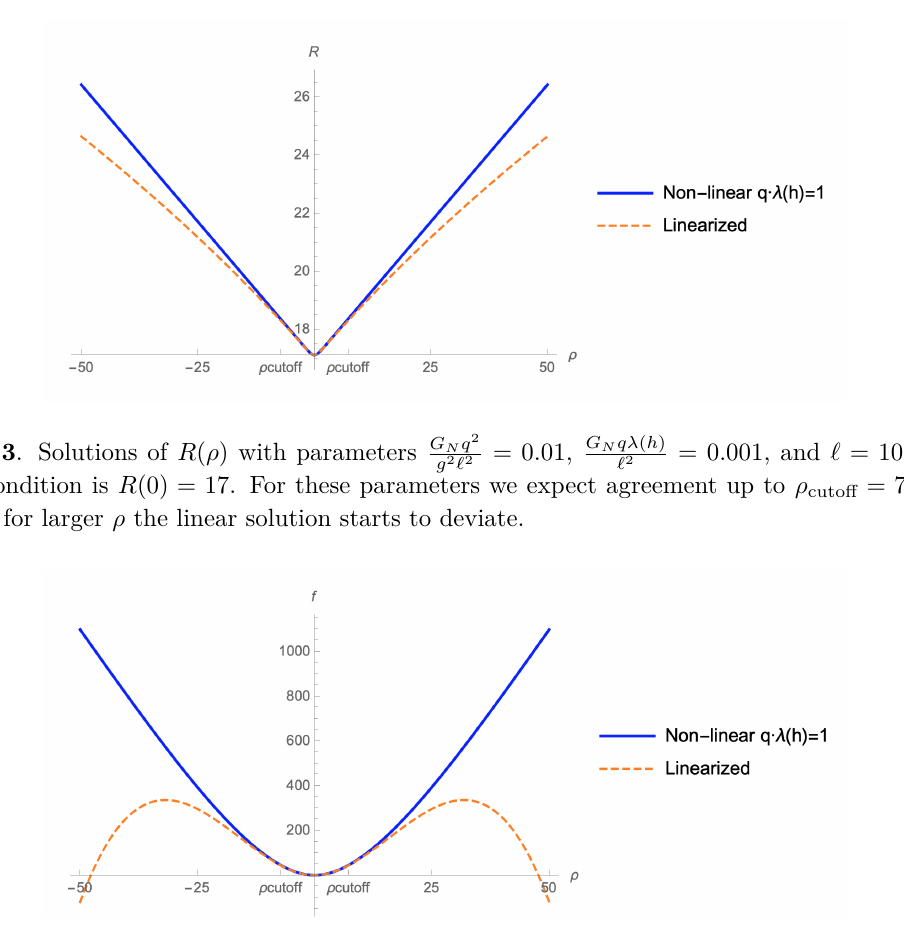
= 0 . 01 , G N qλ ( h ) = 0 . 001 , and ‘ = 100 . The g 2 ‘ 2 ‘ 2